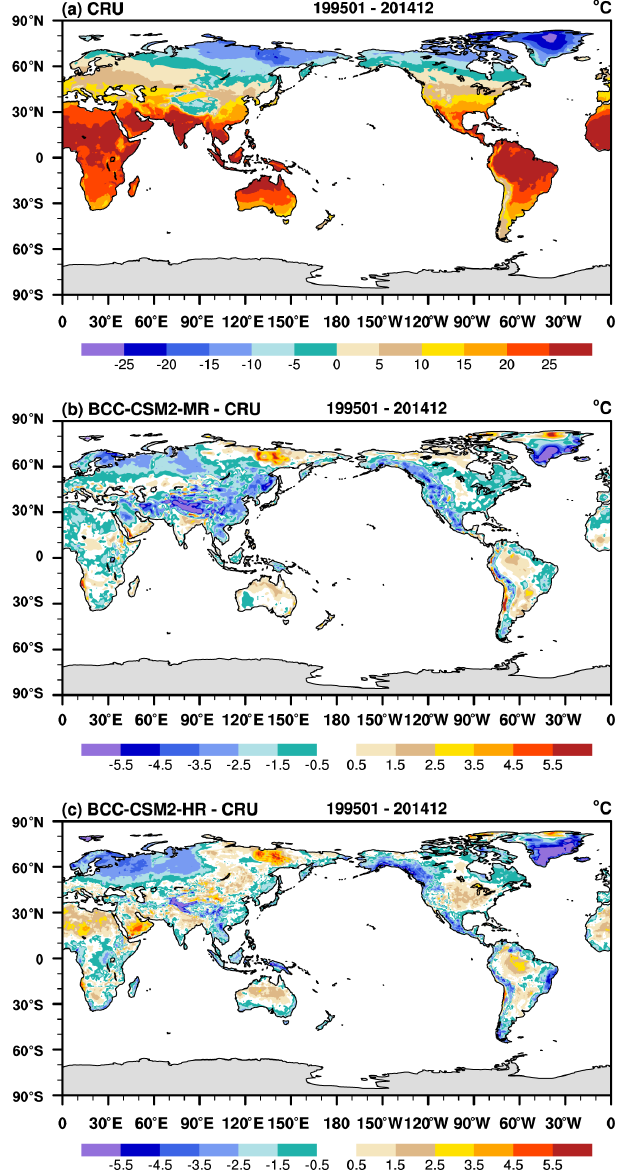
Figure 11. The 1995–2014 averaged global land–surface air tem- perature for (a) CRUTEM observations, and simulation biases in (b) BCC-CSM2-MR and (c) BCC-CSM2-HR.